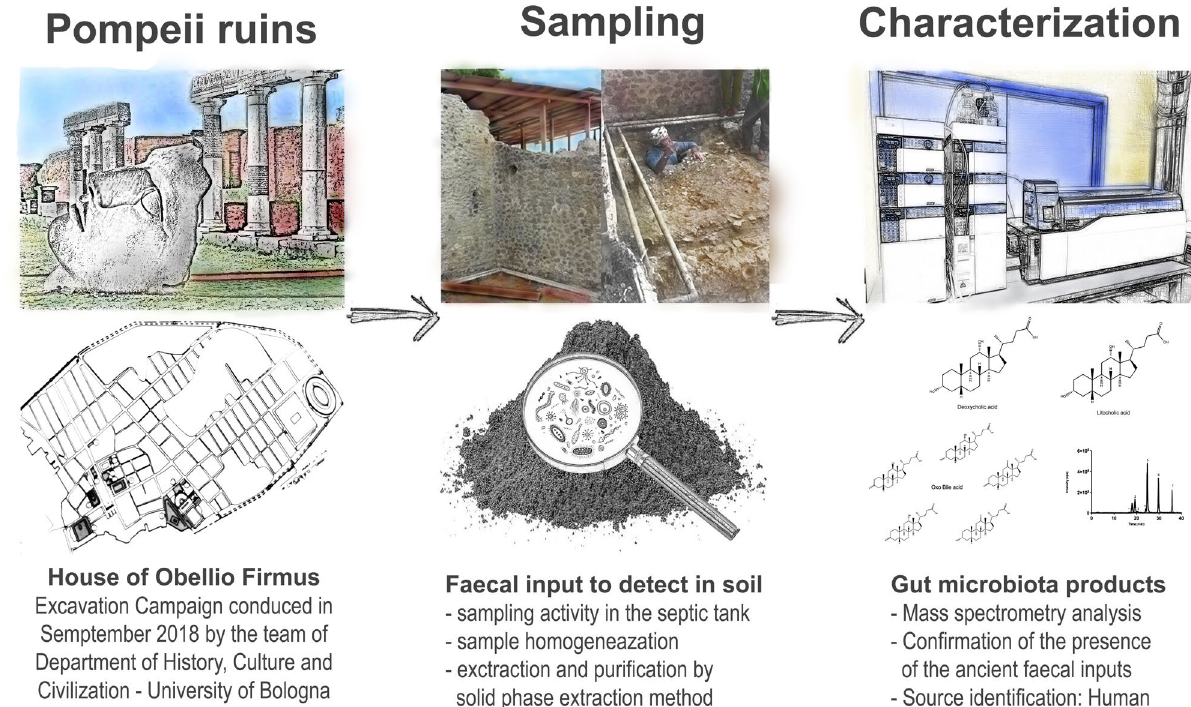
Figure 1. Workflow with steps to characterize the soil samples from